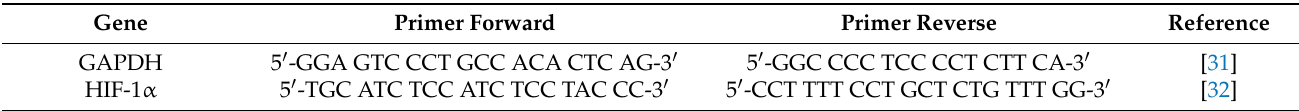
Table 1. Primer used for detecting HIF-1 α gene expression. Gene Primer Forward Primer Reverse